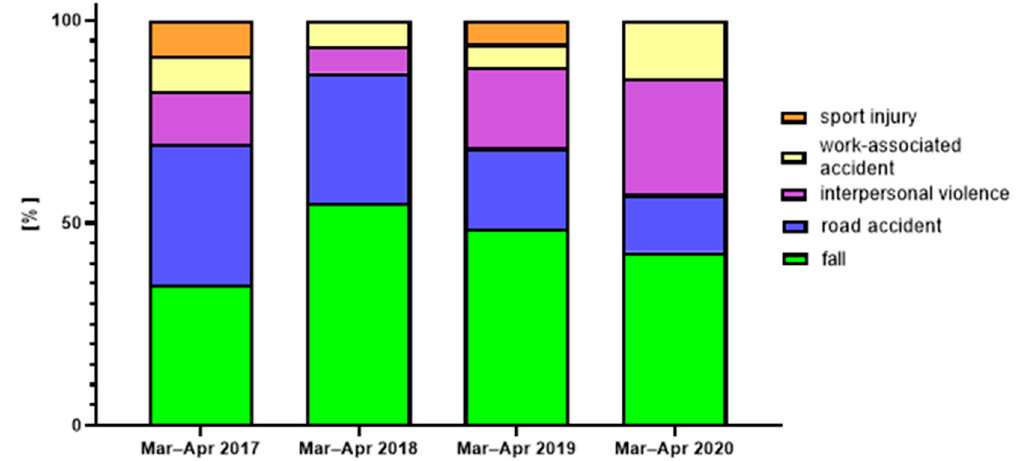
Figure 5. Etiology of OMF fractures admitted to the GMC trauma center during March and April in